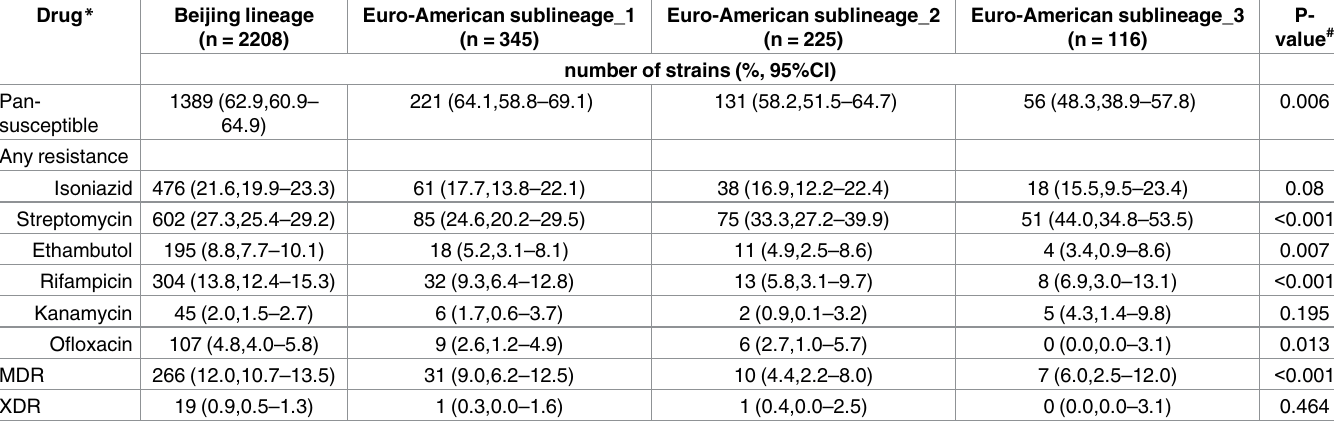
were streptomycin mono-resistant, which was more than that in any other major complex. Streptomycin mono resistance varied from 11% to 22% in the other complexes tested. We also compared the proportion of strains with resistance to streptomycin and/or rifampi- cin in each complex (Table 3). Interestingly, we observed no significant difference in rifampi- cin resistance in the absence of streptomycin resistance among these four largest complexes (p = 0.411), although we again observed a significant difference in streptomycin resistance in rifampicin sensitive strains of the different complexes, with the highest proportion of 41% in Euro-American sublineage_3 and the lowest of 18% in Beijing lineage(p < 0.001). On the con- trary, resistance to both streptomycin and rifampicin was highest in Beijing lineage (9%) and lowest in Euro-American sublineage_3 (3%, p = 0.008). Accordingly, MDR strains in Beijing lineage showed higher resistance level to streptomycin (74%, 196/266) than non-MDR strains in Beijing lineage (21%, 406/1942, p < 0.001); while this difference was not significant in Euro- American sublineage 3 (57%, 4/7 and 43%, 47/109, respectively; p = 0.698). Complexes also revealed different degrees in clustering (Table 4). The overall cluster rate was 38%. Beijing lineage showed the highest cluster rate (48%, p < 0.001). Within Euro-Ameri- can lineage, the three sublineages also differed significantly in degree of clustering: Euro- Table 2. Drug resistance per